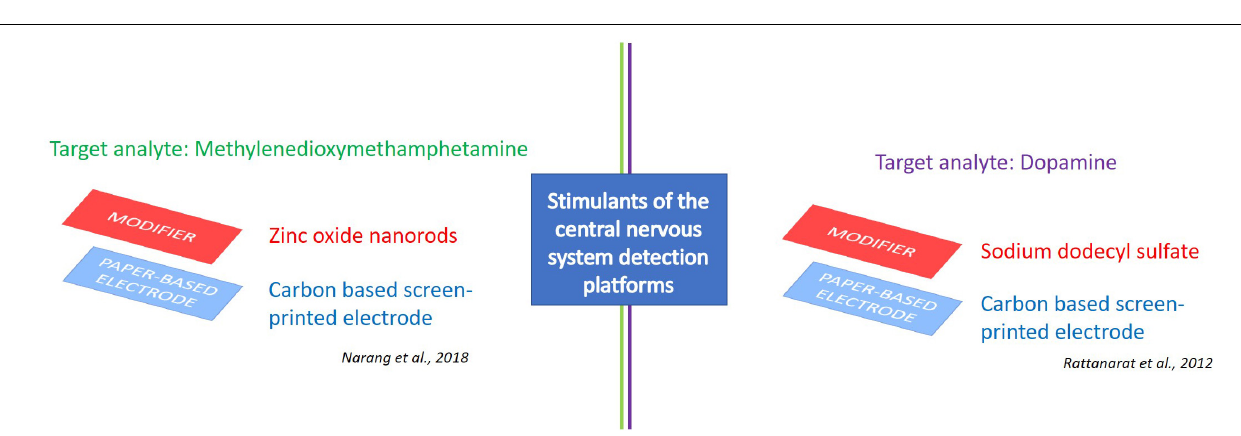
procedures (e.g., ELISA and chromatography) (¸Sim¸sek et al., 2015; Lim et al.,